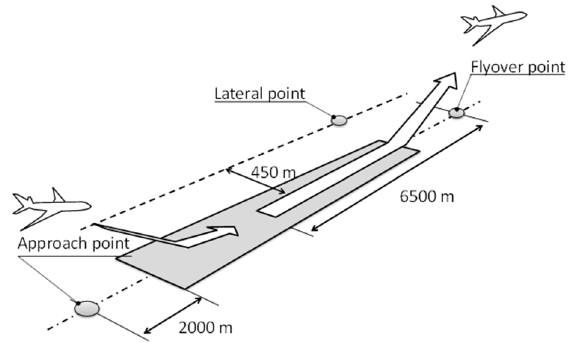
Figure 1. Schematic of reference noise measurement points.